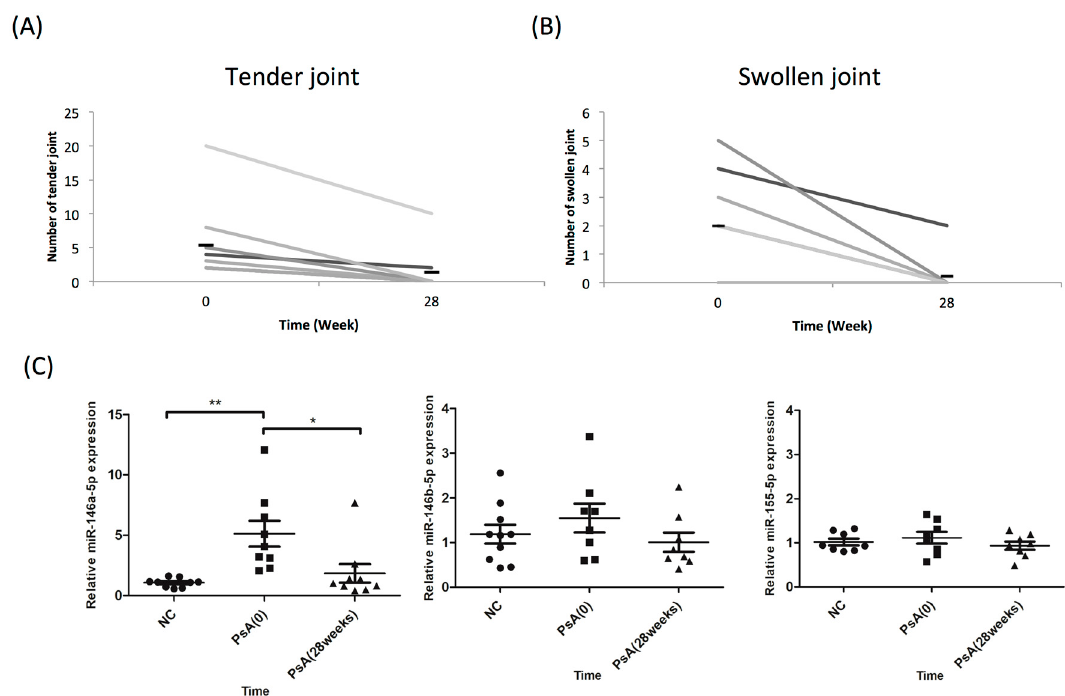
Figure 4. CD14 + monocytes from PsA patients showed reduced miR-146a-5p expression, but not miR-146b-5p or miR-155, following successful treatment. The expression levels of miR-146a-5p were measured in CD14 + monocytes derived from NCs and PsA patients both before and after successful treatment. ( A ) The number of tender joints before and after biological treatment for 28 weeks in patients with PsA. ( B ) The number of swollen joints before and after biological treatment for 28 weeks in patients with PsA. ( C ) miR-146a-5p, miR-146b-5p, and miR-155-5p expression levels were measured using qRT-PCR in CD14 + monocytes from 10 NCs and 10 patients with PsA, before and after treatment with biologics for 28 weeks. * p < 0.05; and ** p < 0.001.